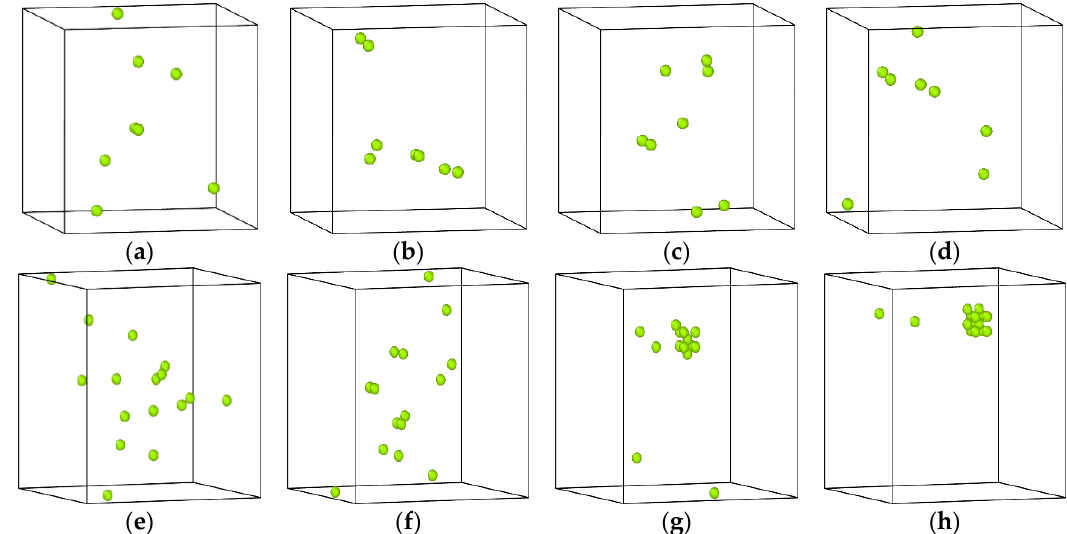
Figure 5. Distribution morphology of vacancies in the system when Fe-3.5Cu-0.1V and Fe-3.5Cu-0.2V alloys are aged for different times. For Fe-3.5Cu-0.1V alloy where ( a – d ) are 0 ns, 40 ns, 132 ns and 186 ns, respectively, and Fe-3.5Cu-0.2V alloy where ( e – h ) are 0 ns, 5 ns, 10 ns, and 132 ns, respectively.